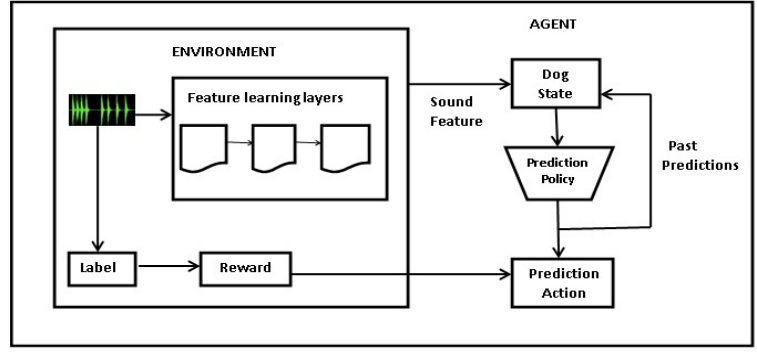
Figure 4. Reinforcement learning method for dog sound predictions.